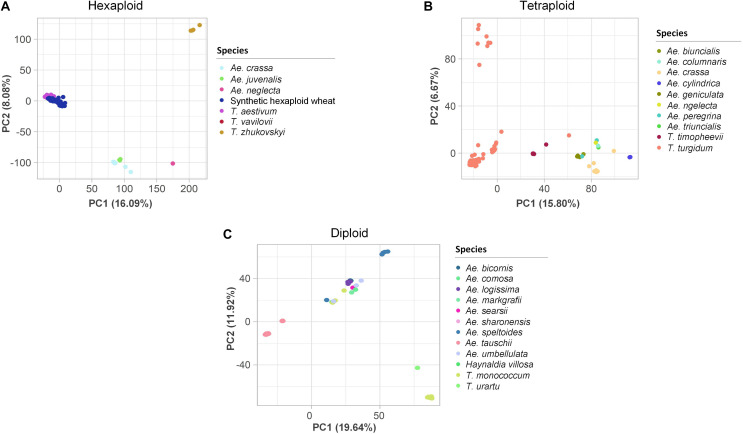
Two-dimensional scatter plots of the first two principal components (PCs) estimated for the (A) hexaploid, (B) tetraploid, and (C) diploid single nucleotide polymorphism datasets. The accessions are colored based on their species. The percentages of the variance explained by each PC are in brackets on the axes.